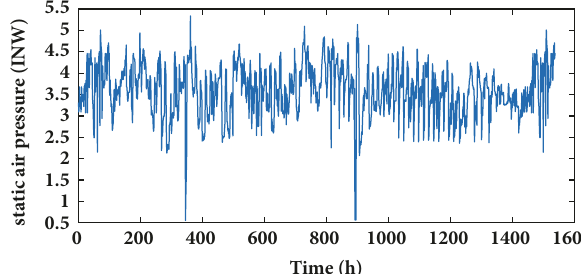
Figure 6: Static air pressure P S (INW).